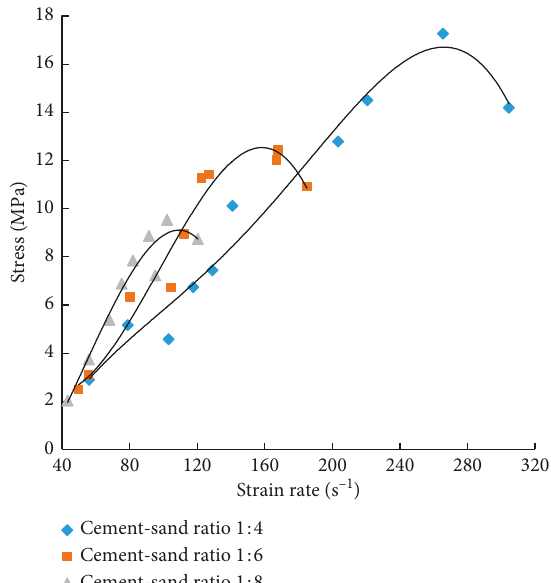
Figure 5: The stress and strain rate curve.